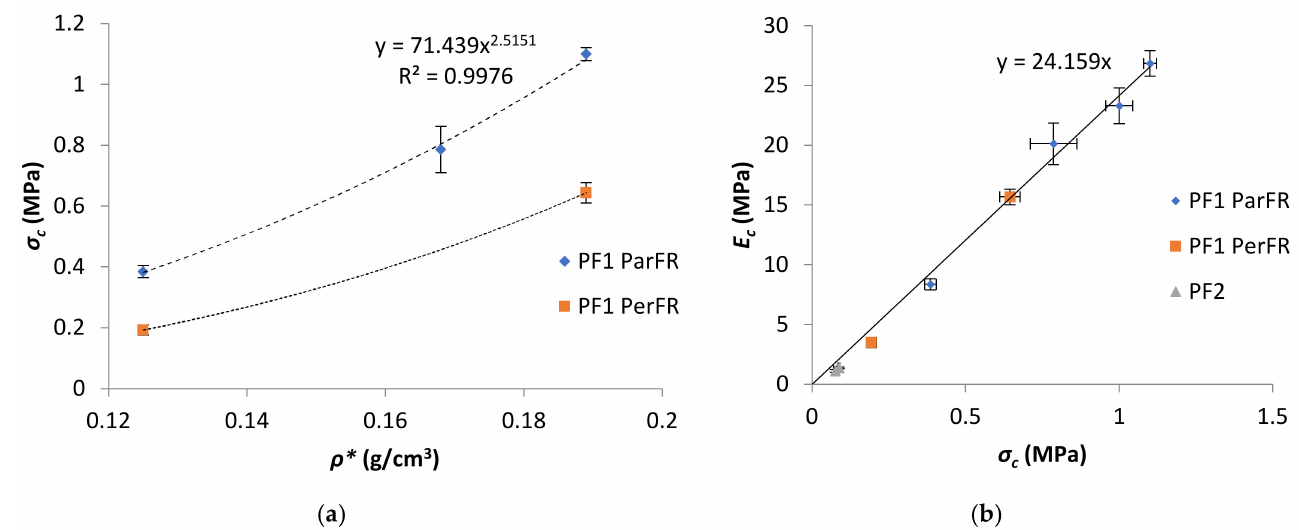
Figure 9. ( a ) σ c as a function of ρ * for PF1 and ( b ) E c as a function of σ c